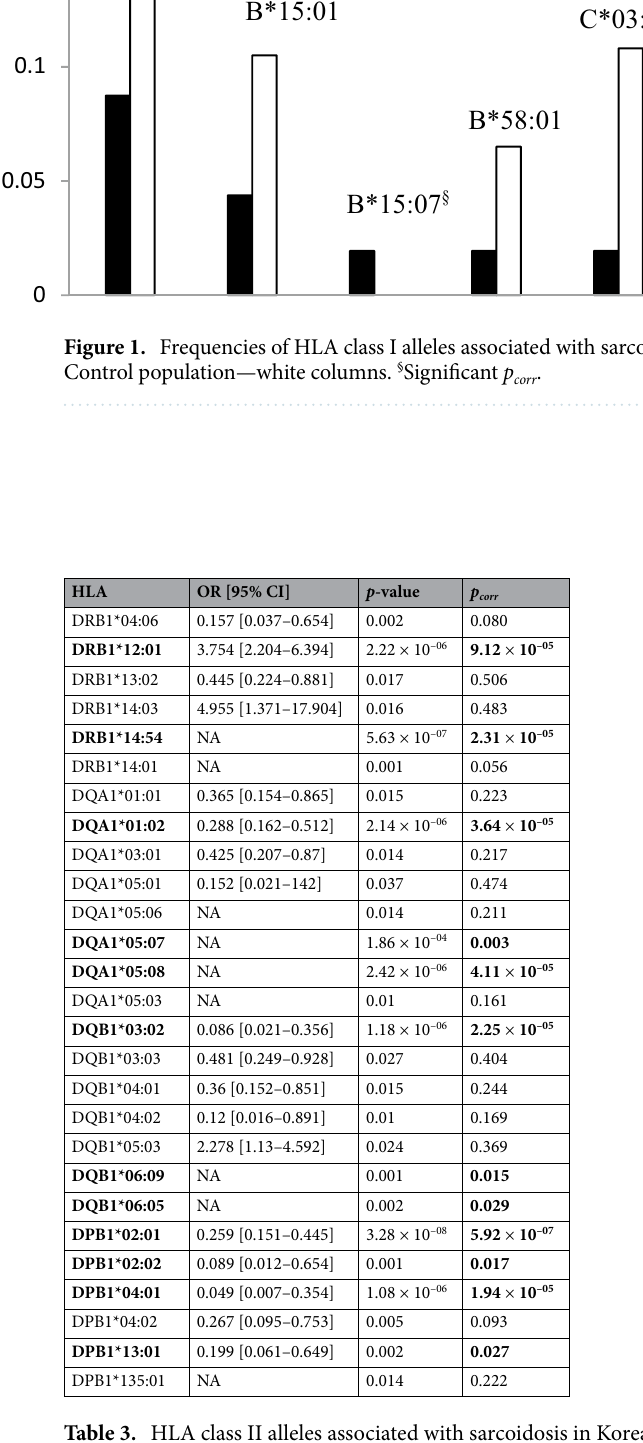
Table 3. HLA class II alleles associated with sarcoidosis in Korean patients (only the alleles associated at least on a primary level are shown). NA not analyzed (no variants were present in one of the analyzed groups), OR odds ratio, CI confidence interval, HLA human leukocyte antigen. Significant p corr ( p -value after correction for multiple comparisons) in